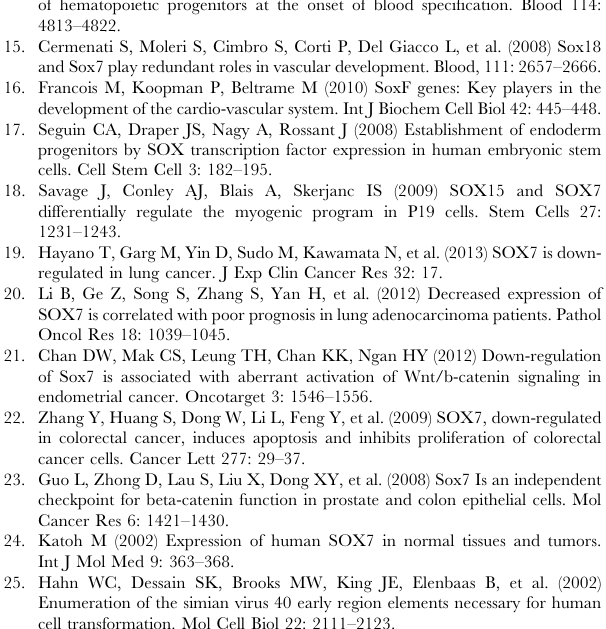
eight paired cancerous tissues (T) and their adjacent noncancerous hepatic tissues (ANT). The average miR-184 expression was normalized using U6 expression. Error bars represent the mean 6 SD from three independent experiments. Figure S2 The proliferative capacity and SOX7 expre- sion of THLE3. A . The proliferative capacity of THLE3 cells and THLE3 cells transfected with miR-184 inhibitor, compared with HCC cells, Hep3B and Huh7, analyzed by the MTT assay. B . The expression levels of SOX7 protein in THLE3 cells, Hep3B and Hep3B transfected with miR-184 inhibitor cells, Huh7 and Huh7 transfected with miR-184 inhibitor cells. Figure S3 The expression of miR-184, and Wnt/ b - catenin signaling related genes in HCC tissues. A . Real- time PCR analysis of miR-184, Cyclin D1, MYC and LEF1 in HCC tissues. B . The correlation between miR-184 expression and Cyclin D1, MYC or LEF1 expression in HCC tissues. Error bars represent the mean 6 SD from three independent experiments, P , 0.05. Figure S4 MiR-184 promotes HCC proliferation by inhibiting SOX7. A . The expression levels of SOX7 in miR- 184-inhibitor transfected HCC cells that were transfected with